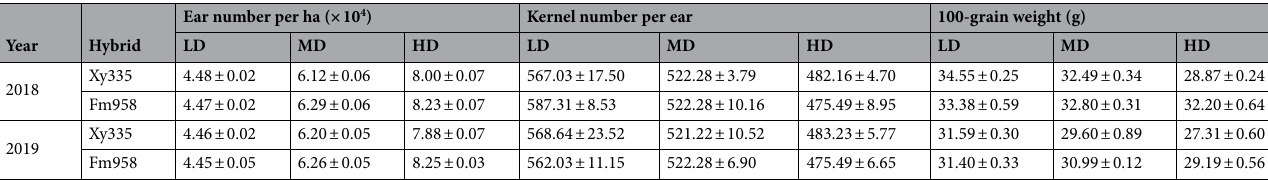
Table 2. Maize yield components under different treatments in 2018 and 2019. LD, MD, and HD represent low, medium, and high planting densities, respectively. Mean ± S.E (n = 3).